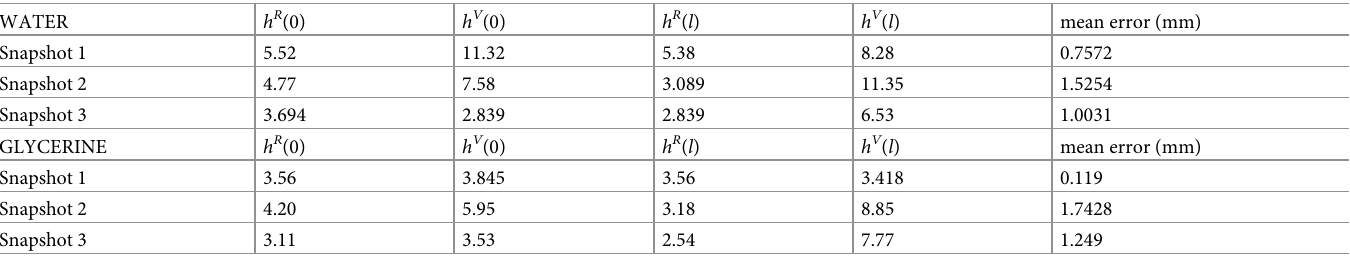
Table 3. Numerical results of the experimental validation. Snapshot number refer to the ones shown in Fig 8.